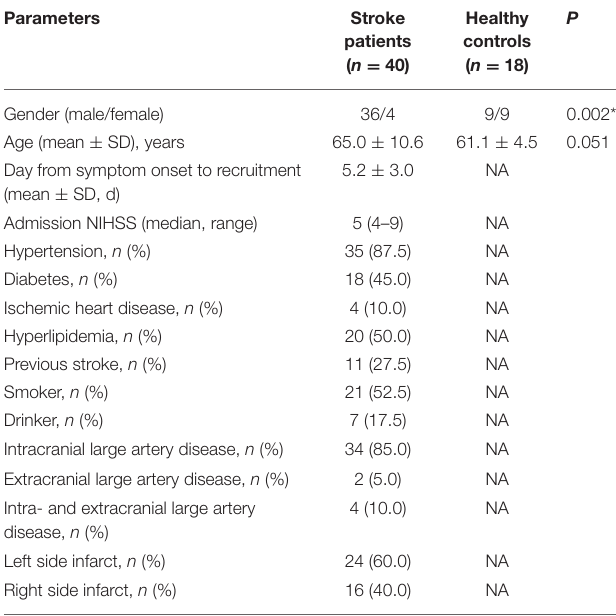
TABLE 1 | Baseline characteristics.